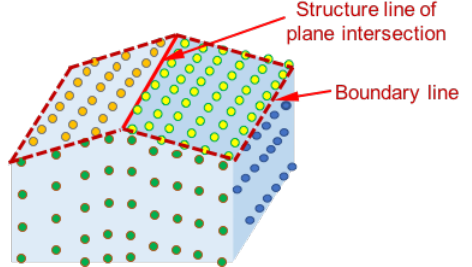
Figure 3. Characteristics of LiDAR point distribution and the the proposed approach to boundary extraction.